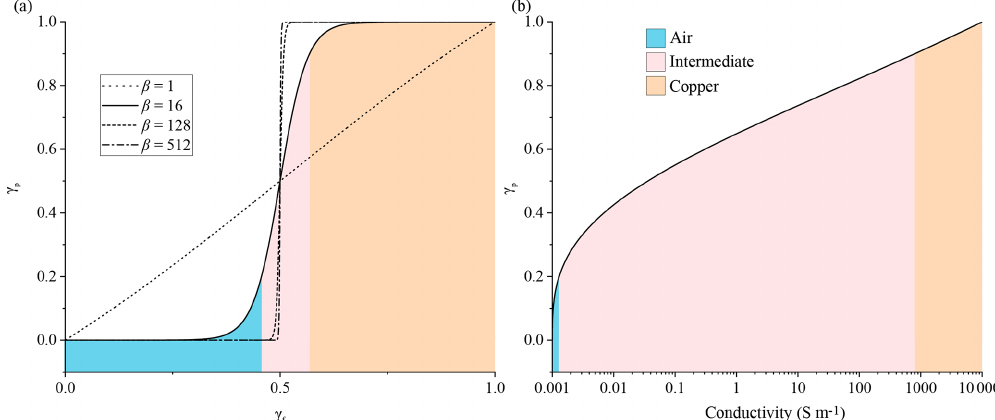
Figure 2. (a) Relationship between γ f and γ p for different values of β . (b) Conductivity values as a function of the projected design variable ( γ p ) on a logarithmic scale calculated from Eq. (13). As β increases, the intermediate contour in (a) decreases, forcing γ p to converge to either air or Cu. In (b) the air and Cu contours represent the range of conductivity values it can have. With increasing β , the contour area for air and copper decreases, forcing it to have a unique value.